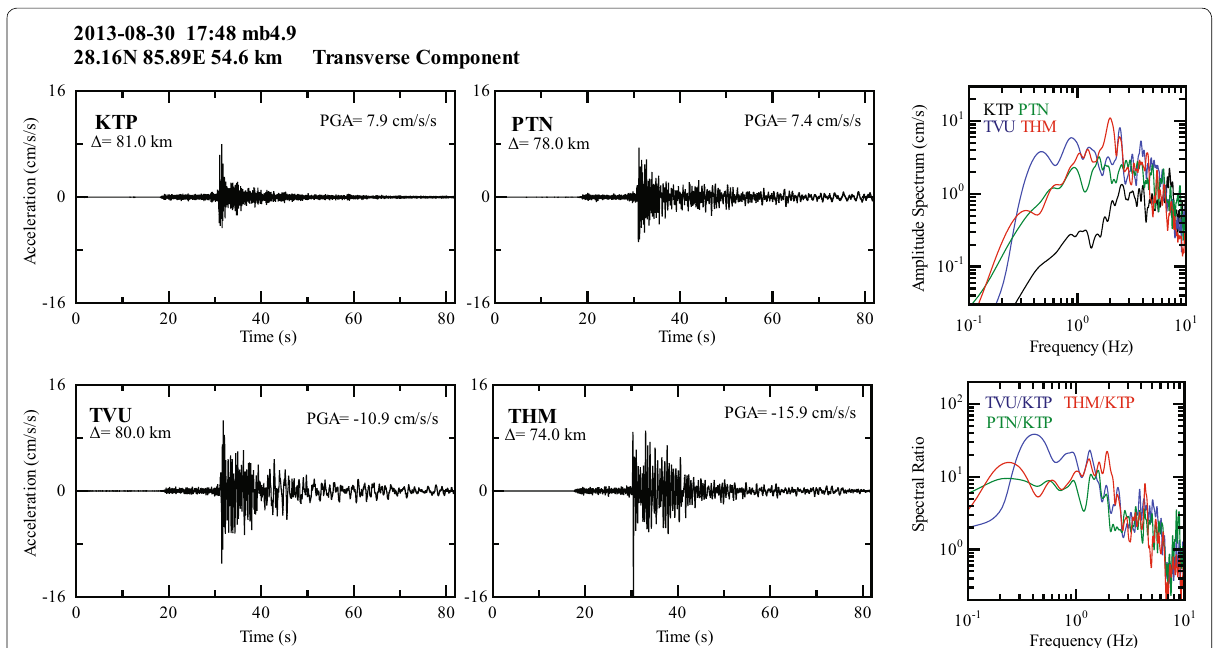
Fig. 2 Acceleration waveforms, Fourier spectra, and spectral ratios of the mb4.9 earthquake for the transverse component. The epicenter of the earthquake is about 80 km NE of Kathmandu. The record of this earthquake was used to adjust the initial 1-D velocity model. A significant